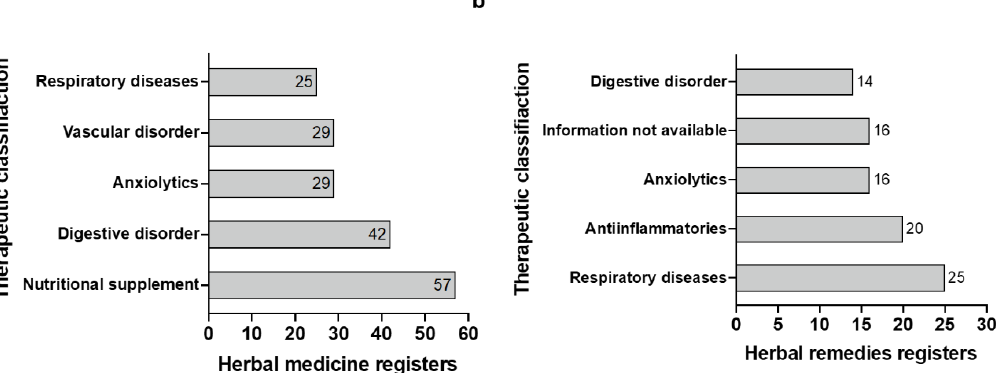
Figure 3. Pharmaceutical forms of ( a ) herbal medicines and ( b ) herbal remedies with sanitary regis- tries in Mexico in the period 2001 – 2020. Data obtained from: COFEPRIS (Comisión Federal para la Prevención de Riesgos Sanitarios). 2022; Listados de Registros Sanitarios de Medicamentos. https://www.gob.mx/cofepris/documentos/registros-sanitarios-medicamentos (accessed on 12 August 2021).